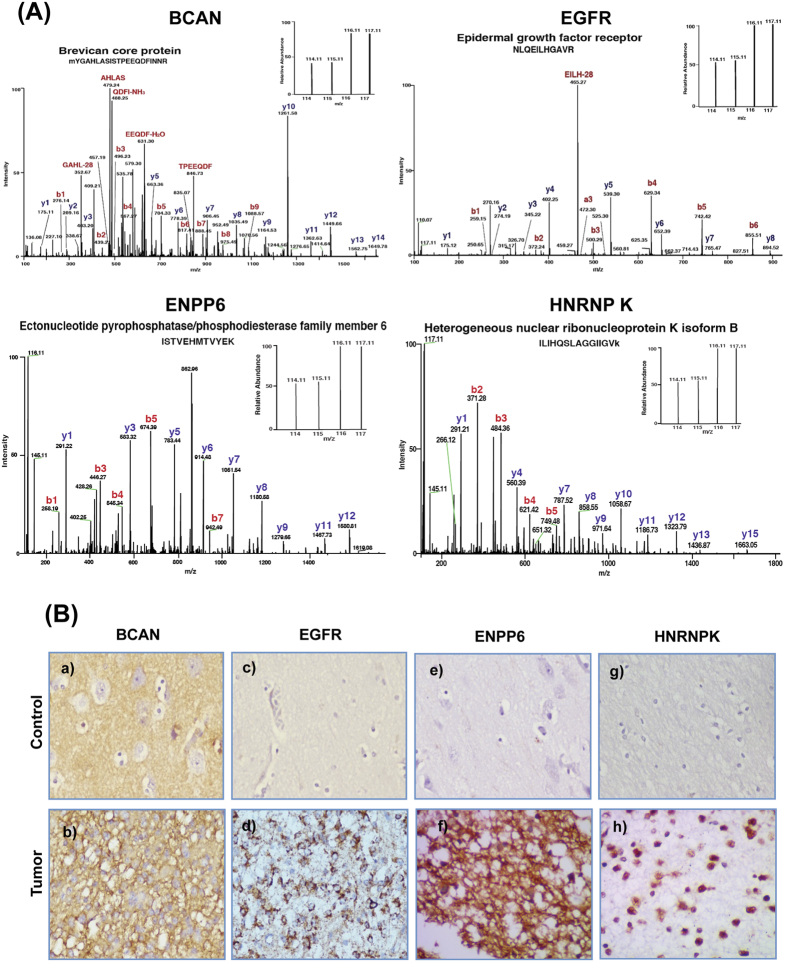
Verification of differential expression of the representative proteins observed in LC-MS/MS analysis by immunohistochemistry on tissue sections.(A) shows MS/MS spectra of peptides with their reporter ion intensities for representative differentially expressed proteins - BCAN, EGFR, ENPP6 and HNRNP K. (B) immunohistochemistry (IHC) images acquired for the above proteins. IHC protocol is described under Methods and the staining and scoring details for each protein are shown in Supplementary Table S3. For BCAN, normal brain tissue shows low staining with pyramidal cells negative (a), Grade II tumor cells show strong cytoplasmic positivity (b). For EGFR, normal brain tissue shows negative staining (c) and Grade II tumor cells show medium intensity cytoplasmic staining (d). ENPP6 shows medium intensity staining of neurophils in normal brain with no staining of normal glial and neuronal cells (e), while Grade II tumor cells show low to medium intensity staining for ENPP6 in neurophil as well as in tumor cells (f). For HNRNP K, normal brain tissue scored negative (g) whereas Grade II tumor cells showed strong positivity (h).